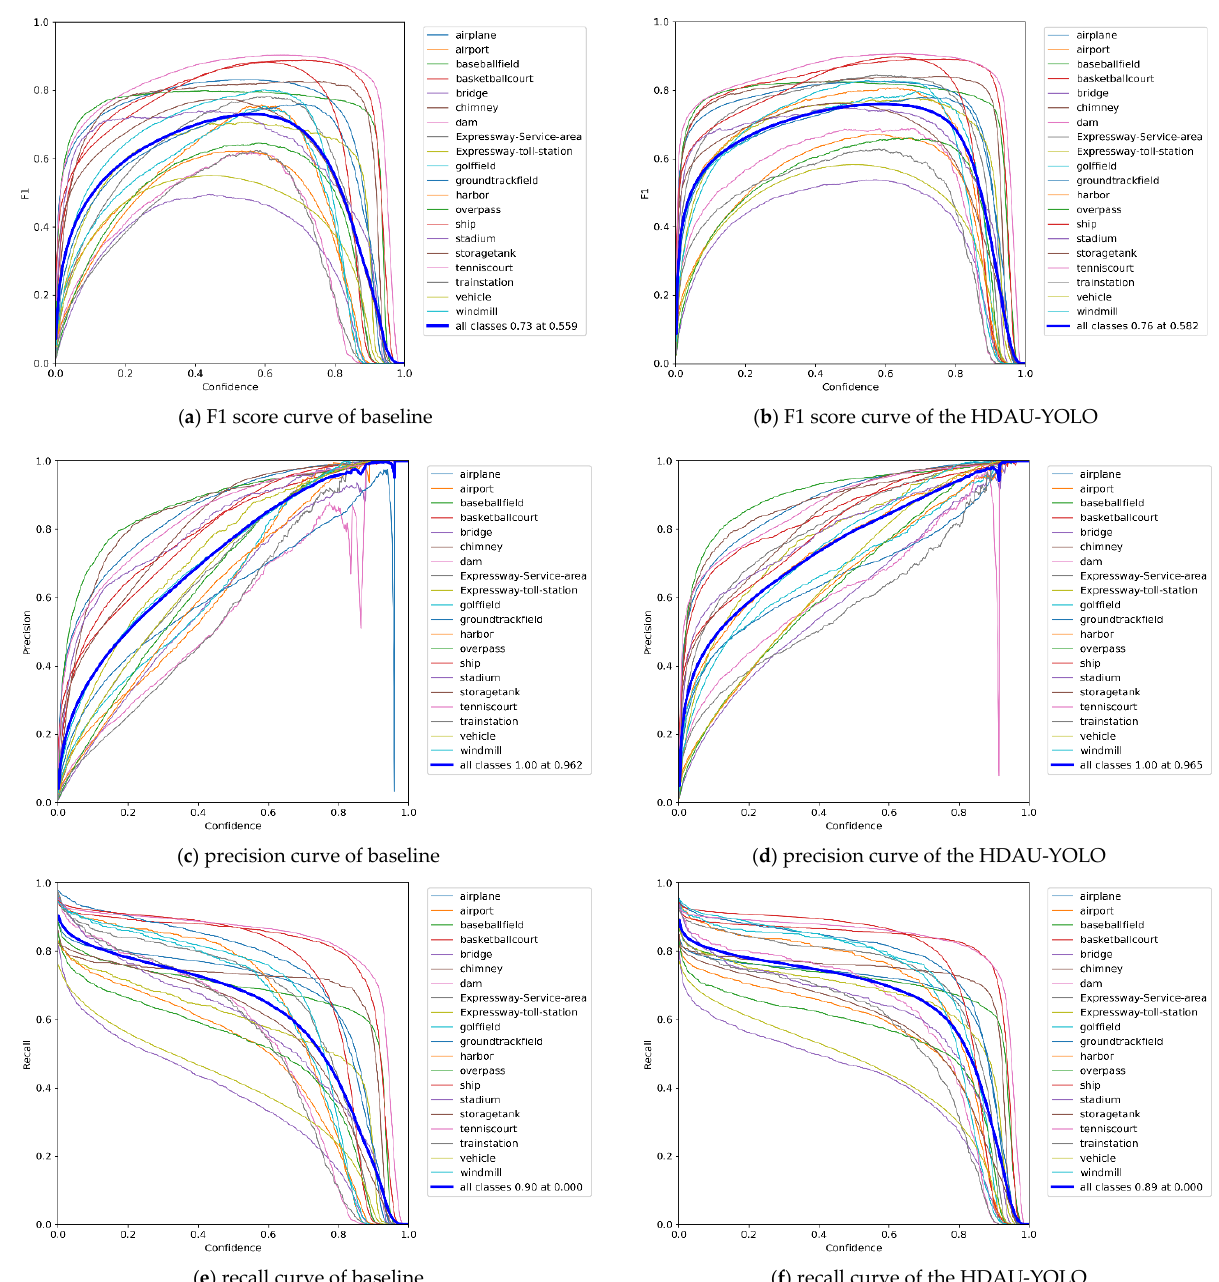
Figure 9. F1 score curves, precision curves, and recall curve analysis on the DIOR test set.